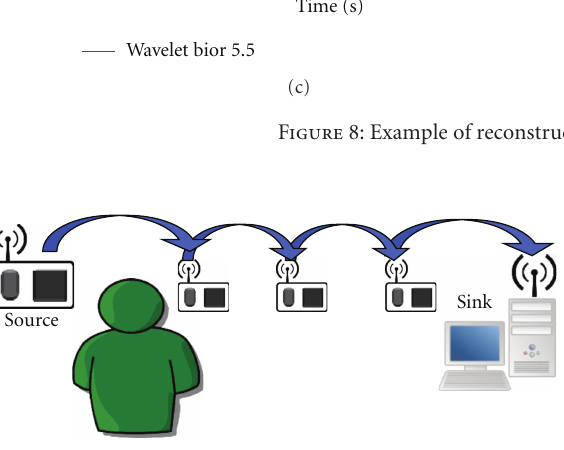
Figure 9: Example TSN, with three intermediate nodes between the source and the sink.